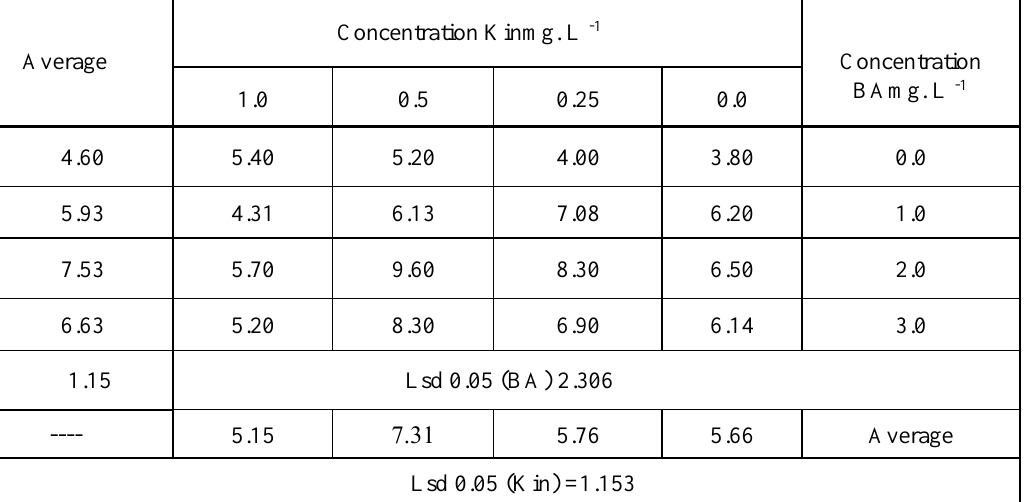
Table 2. Effect of BA and Kin and their interaction on the average leaves number of stevia plant in vitro after four weeks of